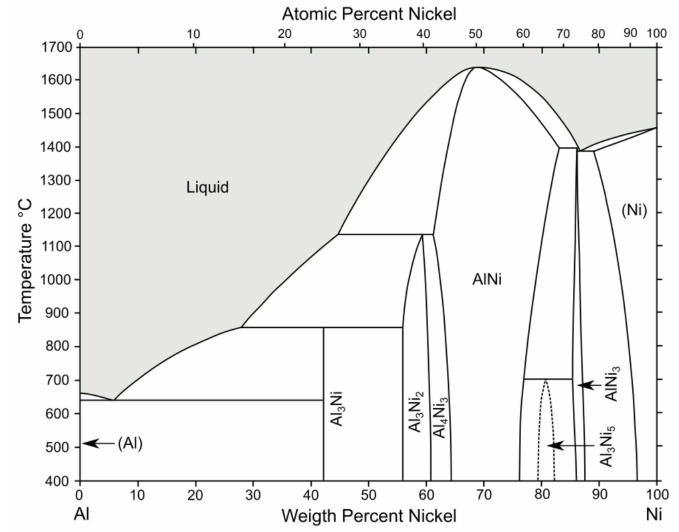
Figure 17. Binary Al–Ni phase diagram. Redrawn from [88] with permission.